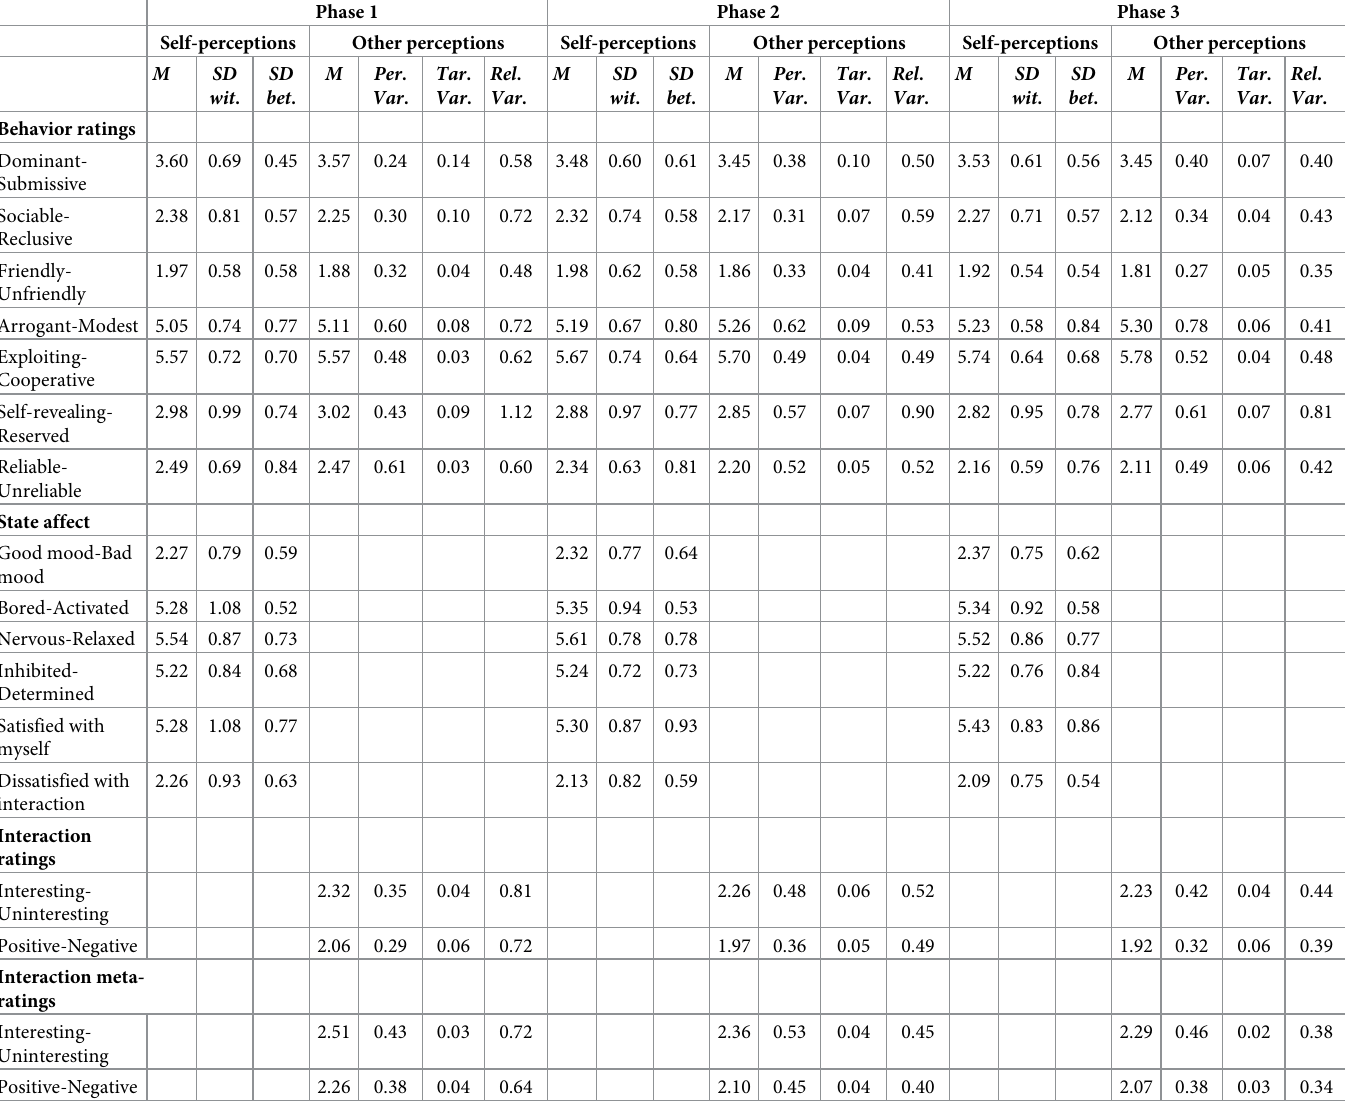
Table 16. CONNECT selected event-based assessment